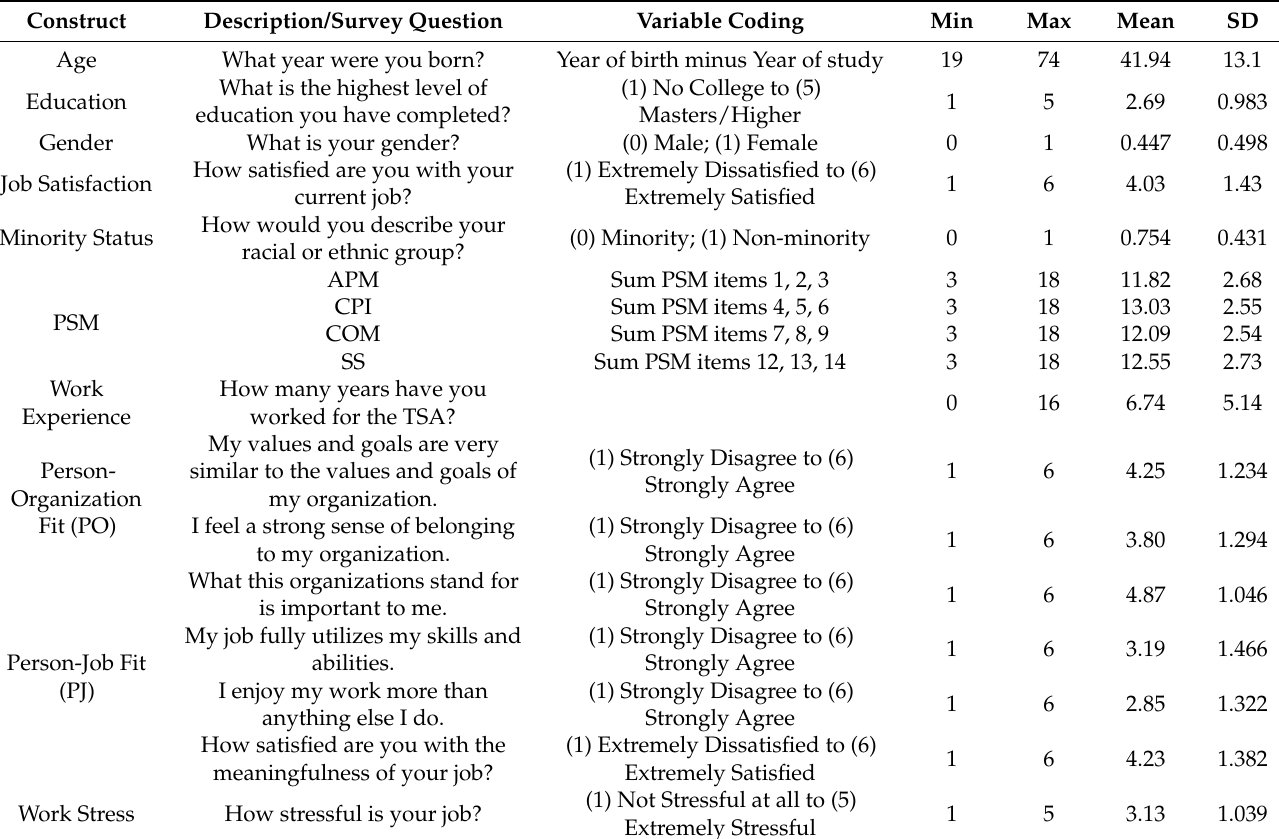
Table 1. Description of study